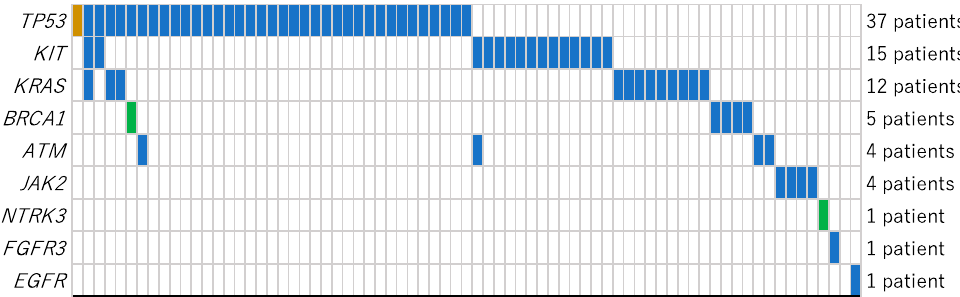
Figure 1. Detailed analysis of the published data of (HM)-SCREEN-Japan 01 [18,19]: Frequencies of tumor-agnostic variants detected among 177 patients with relapsed/refractory or newly diagnosed unfit AML. TP53 (thirty-seven cases), KIT (fifteen cases), KRAS (twelve cases), BRCA1 (five cases), ATM (four cases), JAK2 (four cases), NTRK3 (one case), FGFR3 (one case) and EGFR (one case) are typical genes for which molecular-targeted drugs have been developed or are under development for solid tumors. They are mostly exclusive of each other. Frequent variants are TP53 , KIT and KRAS . TP53 accounts for half of these mutations and 21% of all the examined samples.